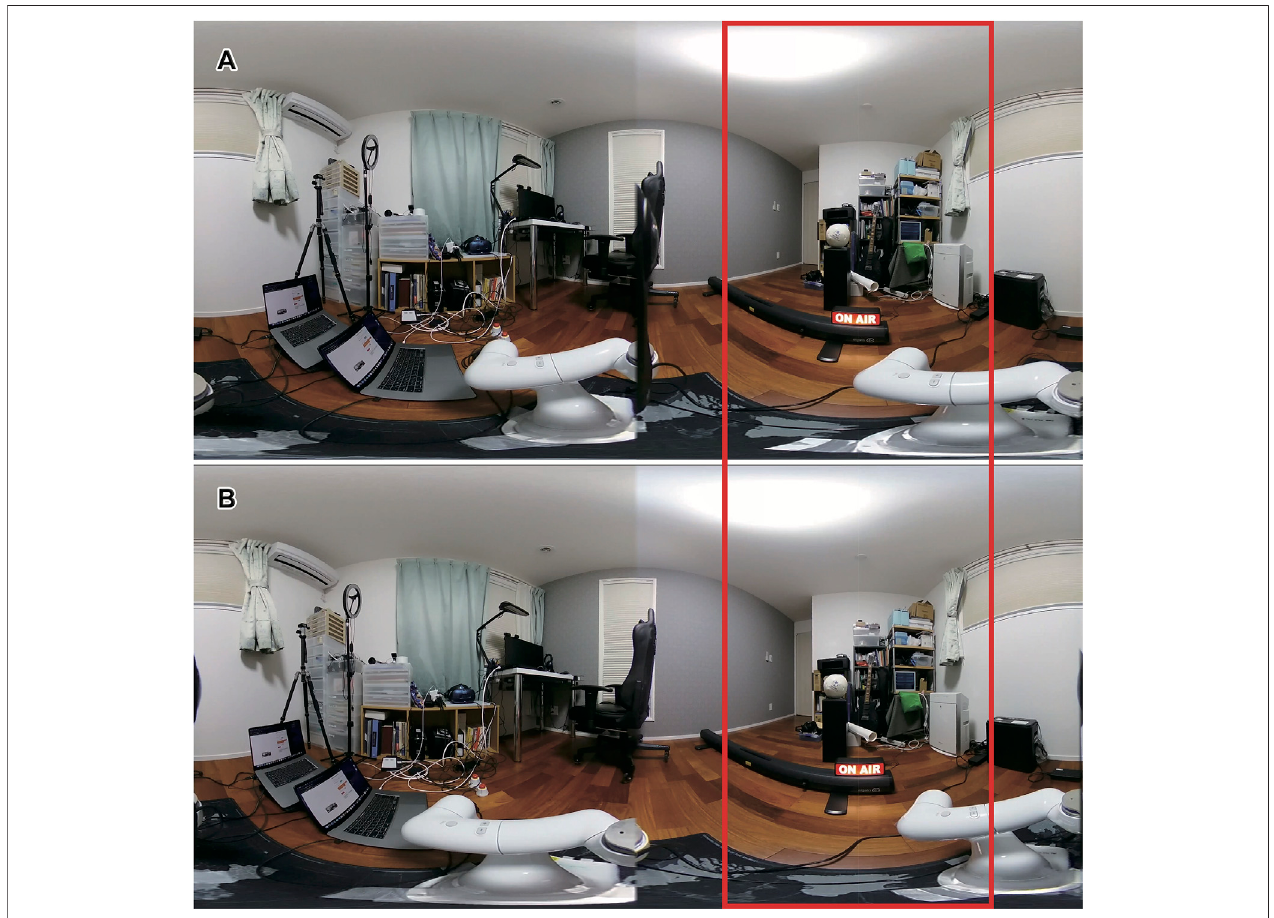
FIGURE 5 | Captured images from the left camera (A) and the right camera (B) . The red frame shows the area displayed on the HMD, which is the front viewing direction of the viewer.